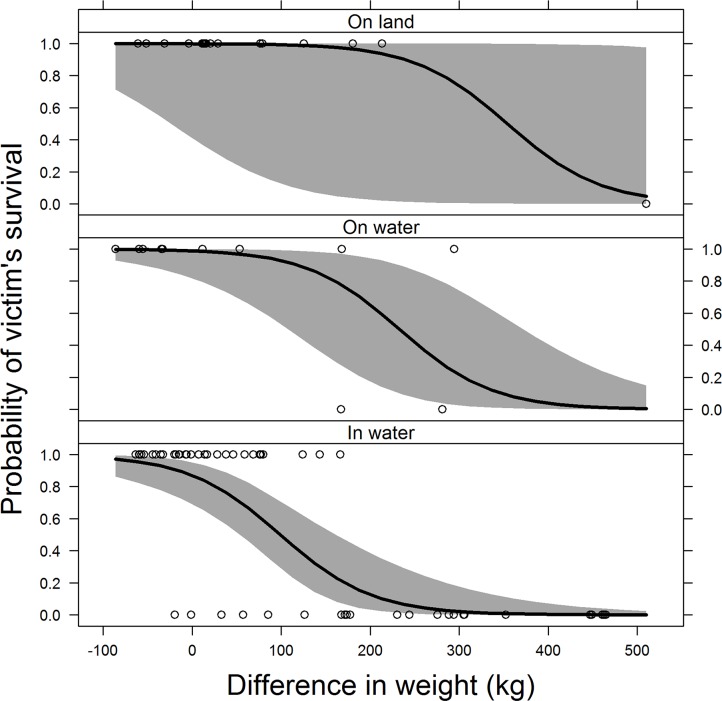
Estimated probability (solid line) that a victim survives a saltwater crocodile attack over the difference in weight between a crocodile and victim in on-land, on-water, and in-water positions.Grey shade is 95% confidence band and open symbols are the raw binary data of crocodile attacks (N = 87).